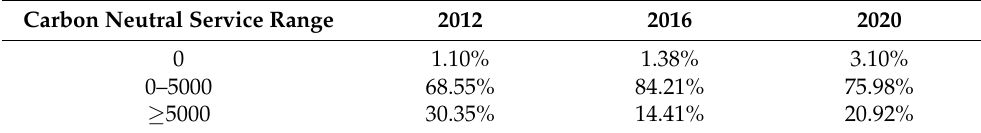
Table 4. Qinling Mountains carbon neutral service scope grade division pixel ratio.